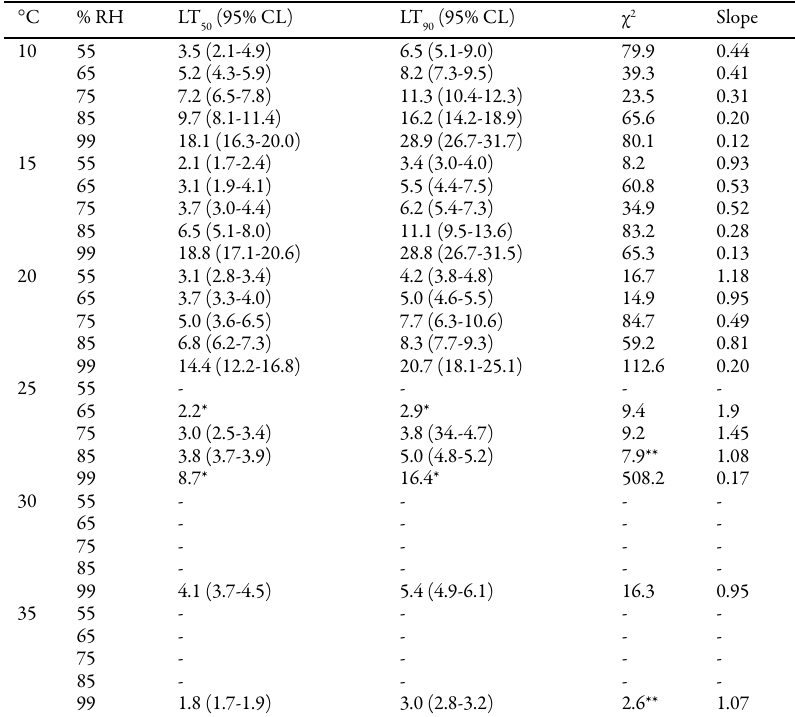
- Probit analysis did not produce LT values because of rapid mortality * Confidence limits are undefined ** p >